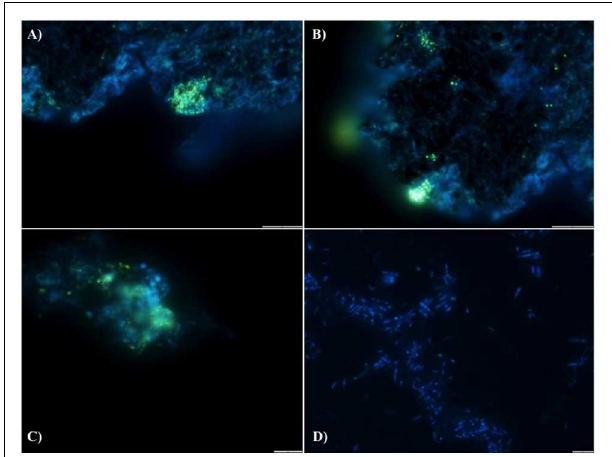
FIGURE 2 | DAPI stained images for the detection of polyphosphate (evidenced by yellow fluorescence) in reactor biomass from (A) Filter Mid-Trial, (B) Filter Mid-Trial, (C): Day 532 and (D) free cells from the filter from the end of the trial.